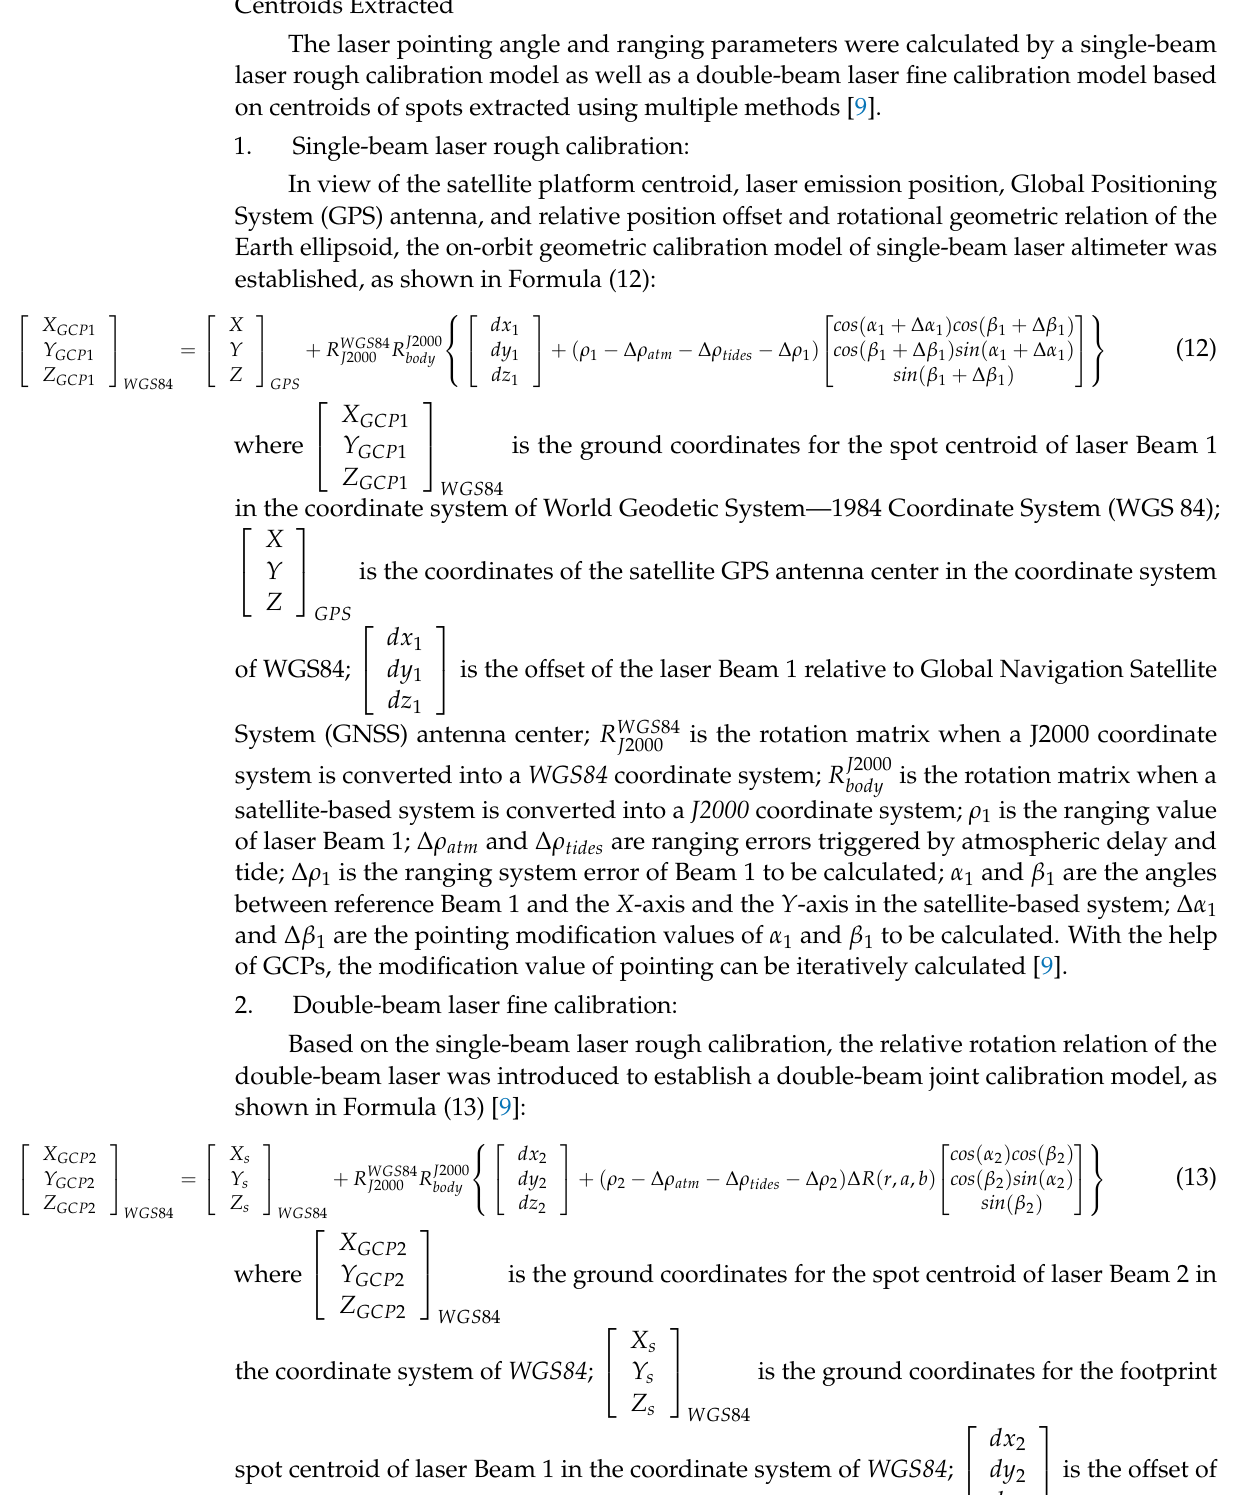
16 of 32 Figure 6. Experimental flow chart. 2.3.1. Centroid Extraction of Spots Based on Infrared Detectors 1. Centroid Extraction of Laser Spots Captured by Infrared Detectors Combining La ‐ ser Footprint Images and Detector Observation Data: